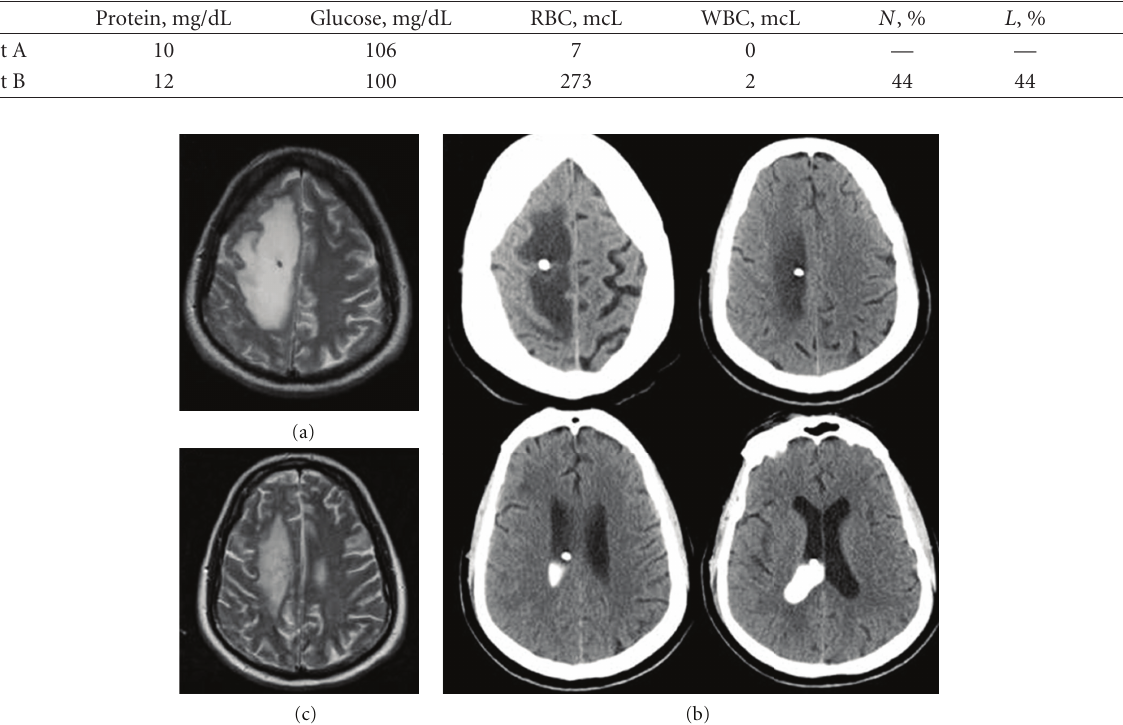
Figure 1: Patient A’s imaging: (a) T2 MRI of the brain on admission. (b) Preoperative ventriculogram, performed through the ventricular reservoir. There is contrast within the ventricle, but it does not pass into the catheter track or the edematous white matter surrounding the catheter. (c) T2 MRI on postoperative day eight demonstrating decreased area of hyperintensity in the white matter compared to preoperative